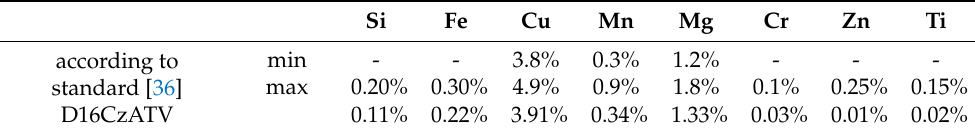
Table 3. Chemical composition of main components (apart from aluminum) of D16CzATV alloy(wt %). Si according